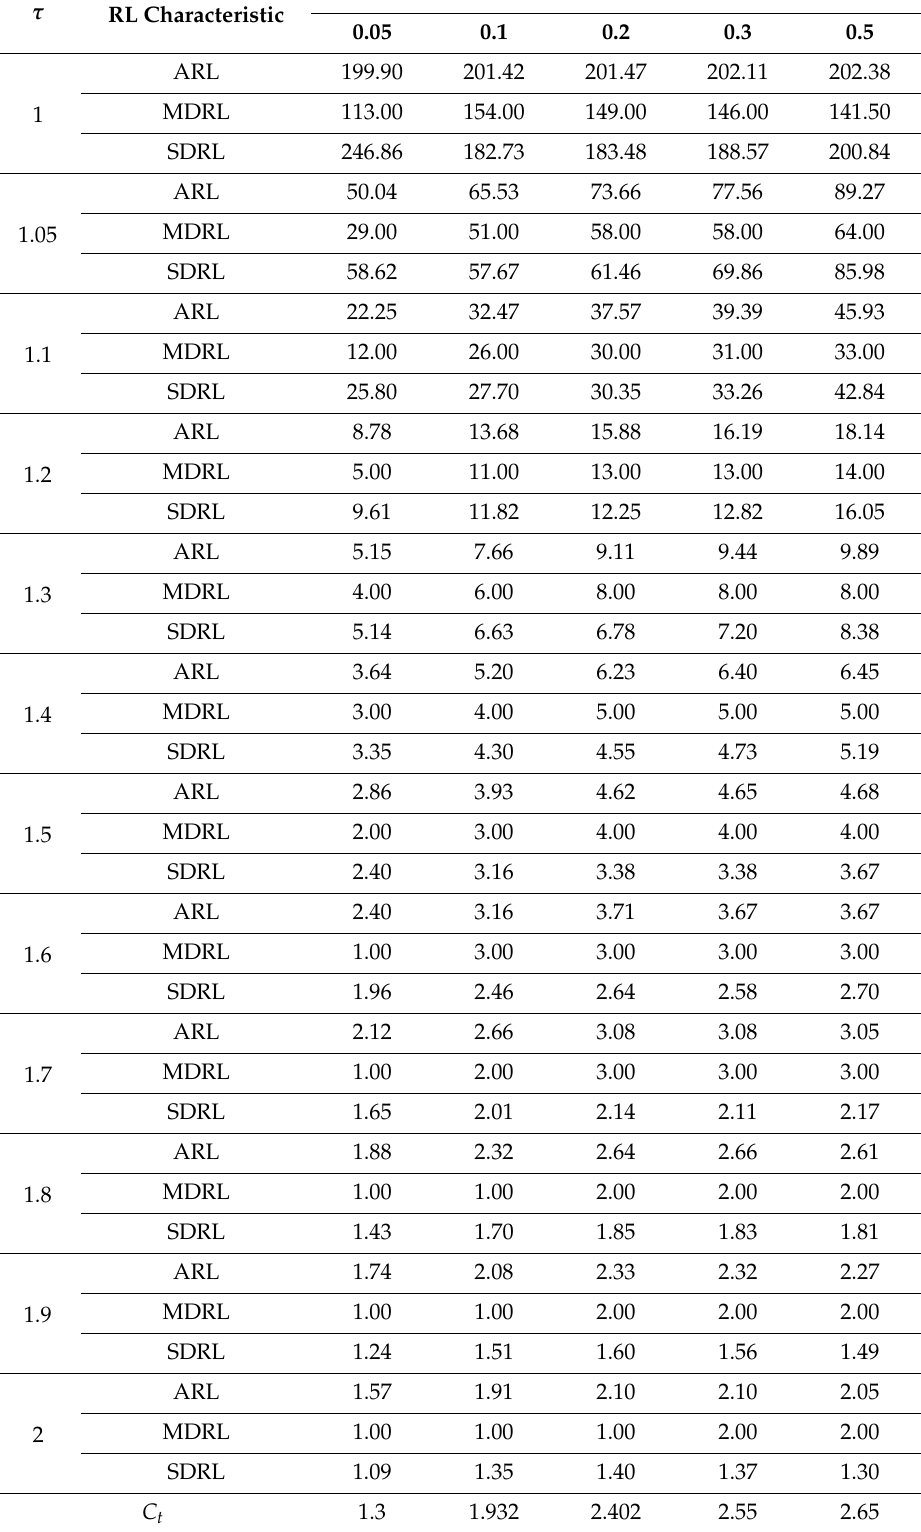
Table 1. The RL profiles of the proposed chart under various choices of λ for n =